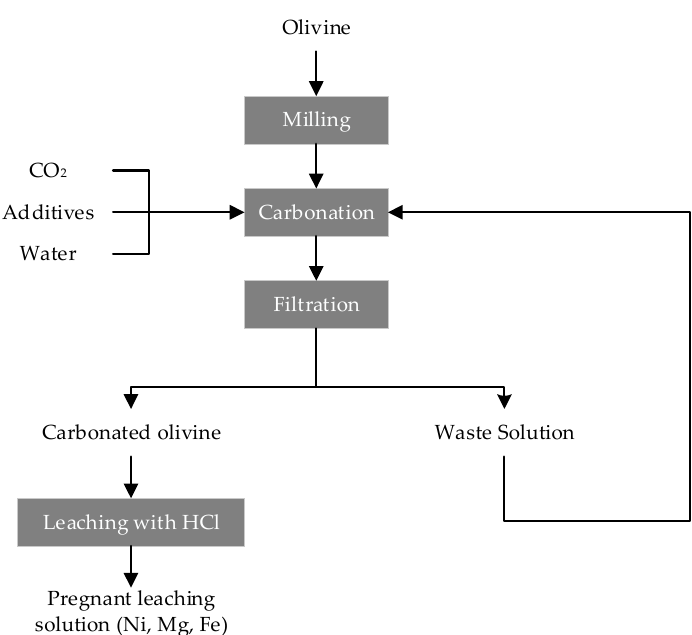
Figure 16. Recovery of nickel, magnesium and iron from olivine bearing ore during leaching with hydrochloric acid including a carbonation pre-treatment.